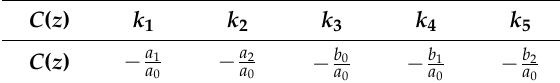
Table 1. Equivalence of parameters for PID